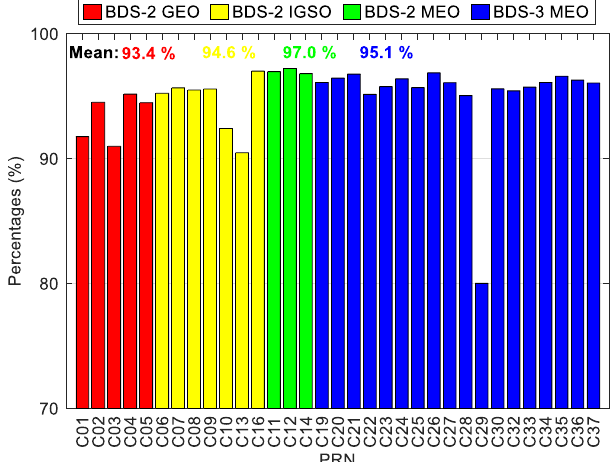
Figure 7. Availability statistics of BDS-3/BDS-2 real-time precise satellite products.